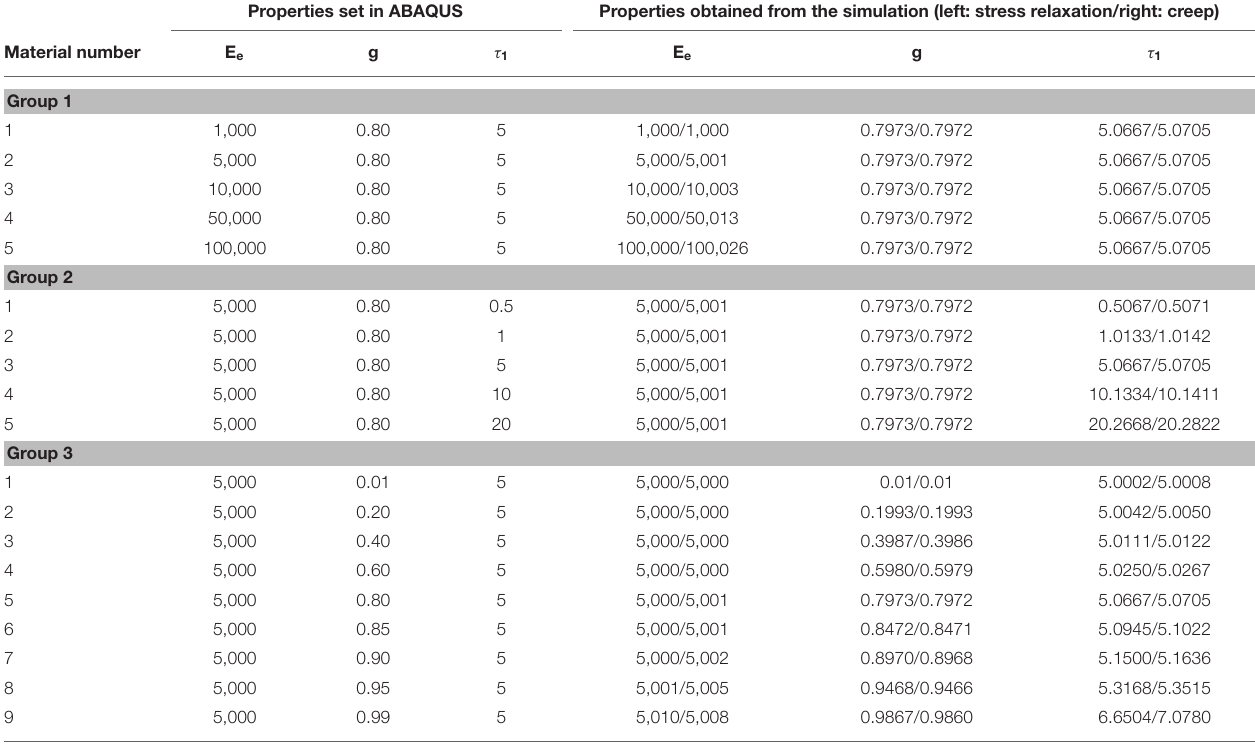
TABLE 1 | Comparison between the values of properties set in ABAQUS and the ones obtained from the simulation. Properties set in ABAQUS Properties obtained from the simulation (left: stress relaxation/right: creep)